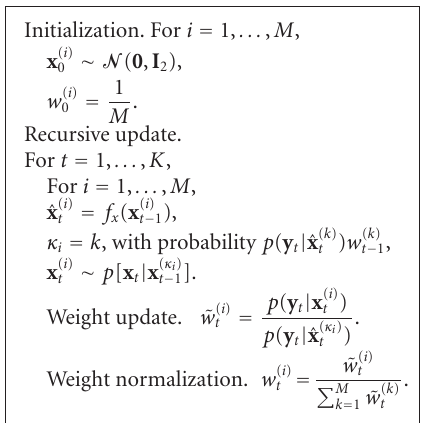
Algorithm 3: Auxiliary BF for the 2-dimensional positioning